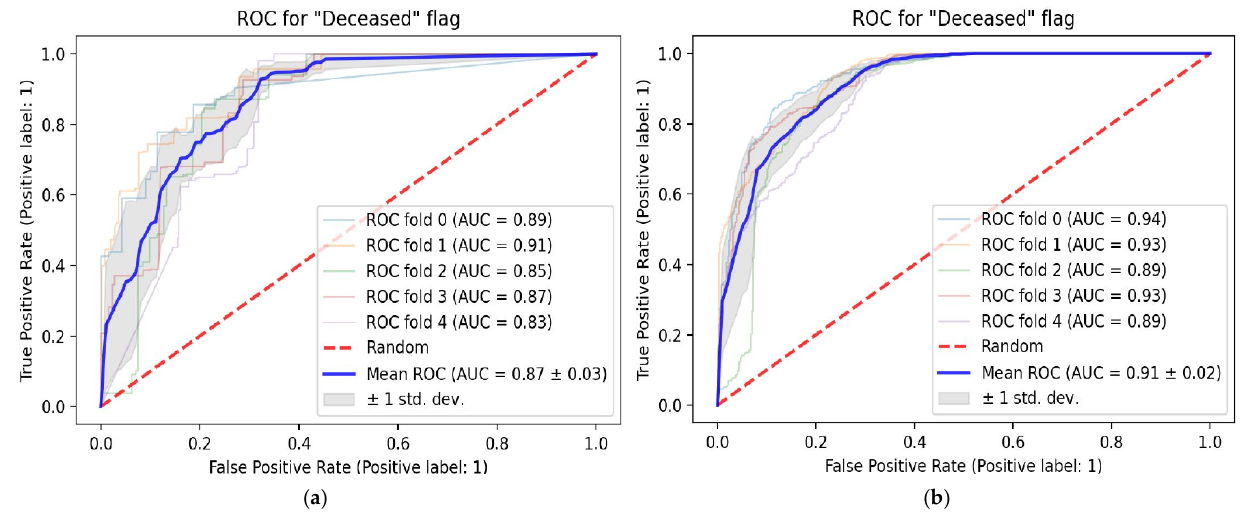
Figure 3. ROC curves showing the performance of prediction models. ( a ) Performance of the model using demographic and non-imaging clinical variables only; ( b ) performance of the model using imaging data and demographic and other clinical variables.